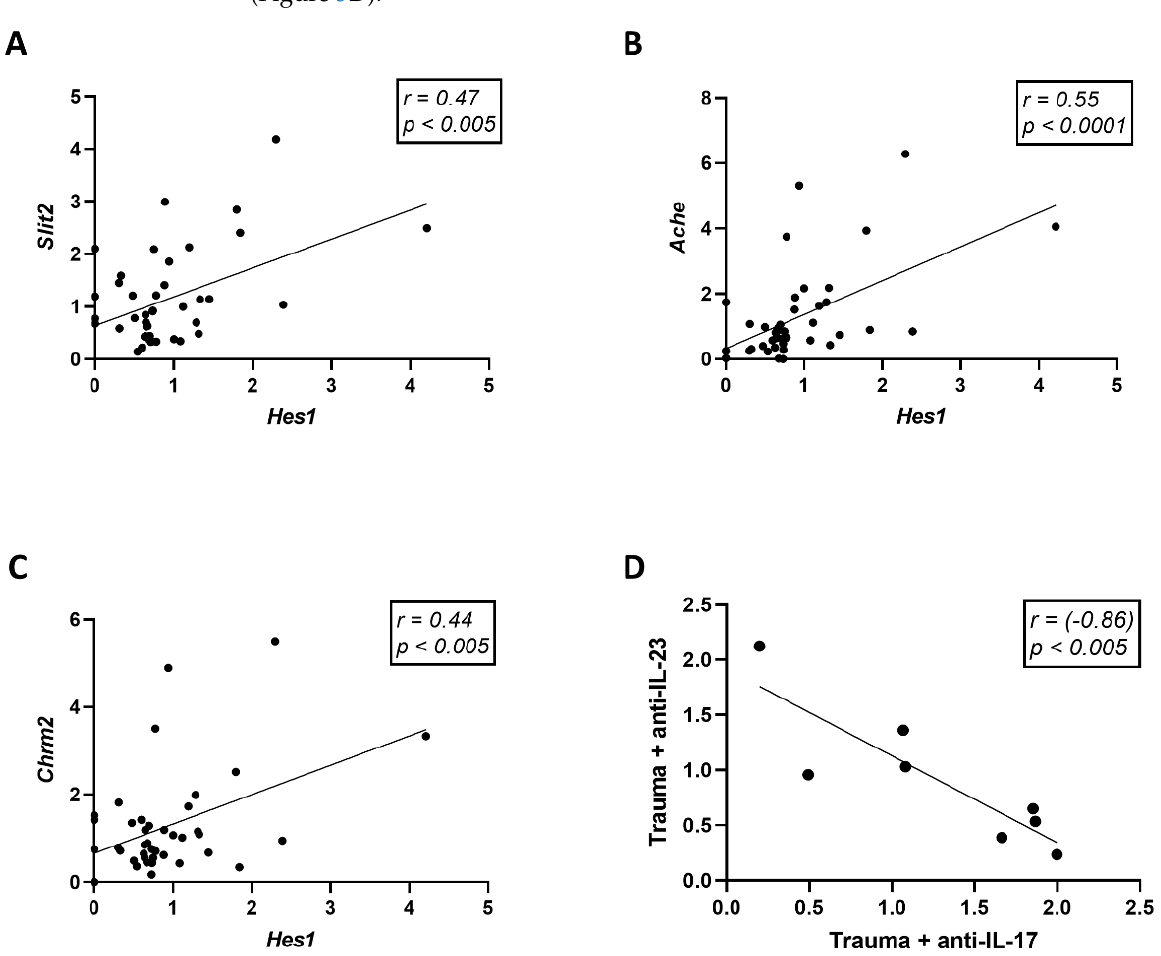
Figure 5. Gene expression correlations. Linear regression graphs depicting the correlation between Hes1 gene expression and Slit2 ( A ), Ache ( B ), and Chrm2 ( C ) gene expression. ( D ) Changes relative to the control group (vehicle, no trauma) for the tested genes and immunohistochemistry (Ki67 and DCX) were plotted for anti-IL-17A and anti-IL-23 treatment groups in trauma exposed animals. Each dot represents a single neurogenesis parameter plotted for the change inflicted by anti-IL-17A treatment against the change inflicted by anti-IL-23 treatment. Correlations were calculated using Pearson test.